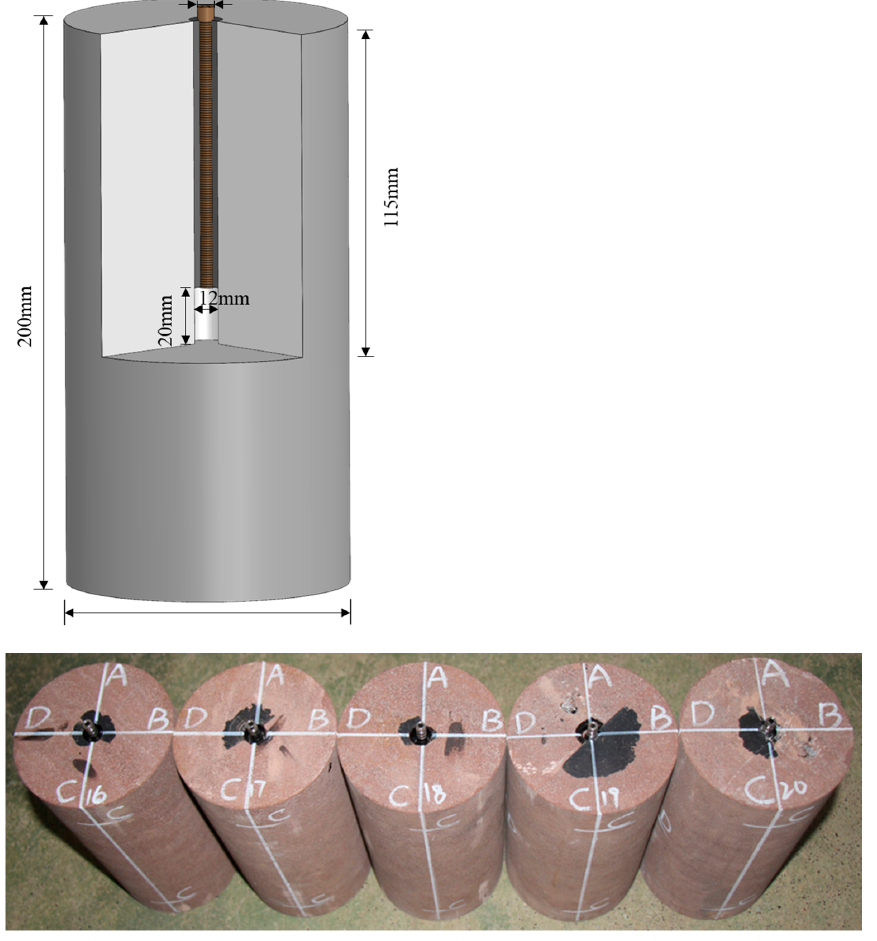
Figure 2. Basic size parameters of tight sandstone